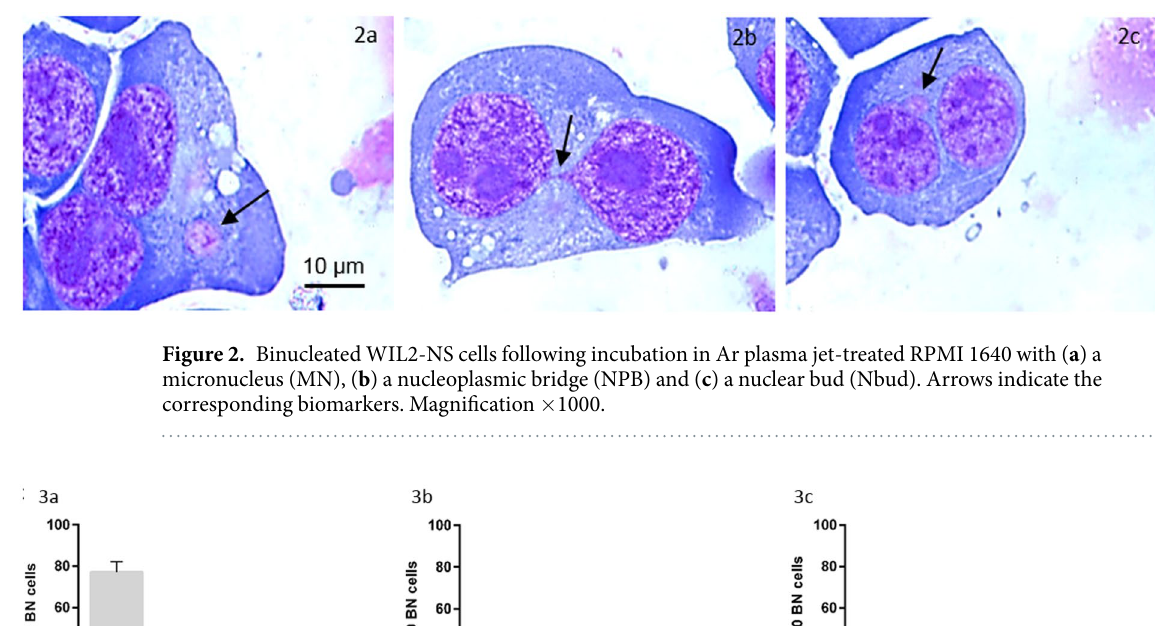
were greatest in the undiluted and less diluted plasma jet-treated media. The WIL2-NS cell is p53 deficient and therefore we would not have expected apoptosis. WIL2-NS cells have a fast rate of division and are more likely to propagate abnormalities in cell division. And in this context our data are different to those of Wende et al . 26 who performed a micronuclei (MN) assay count with HacaT cells (keratinocytes) exposed to plasma-treated media. Wende et al ., based on MN counts, reported no effect of plasma treatment on the cell division process. This dif- ference is not at all surprising as the full CBMN-Cyt assay has revealed markedly different responses in different